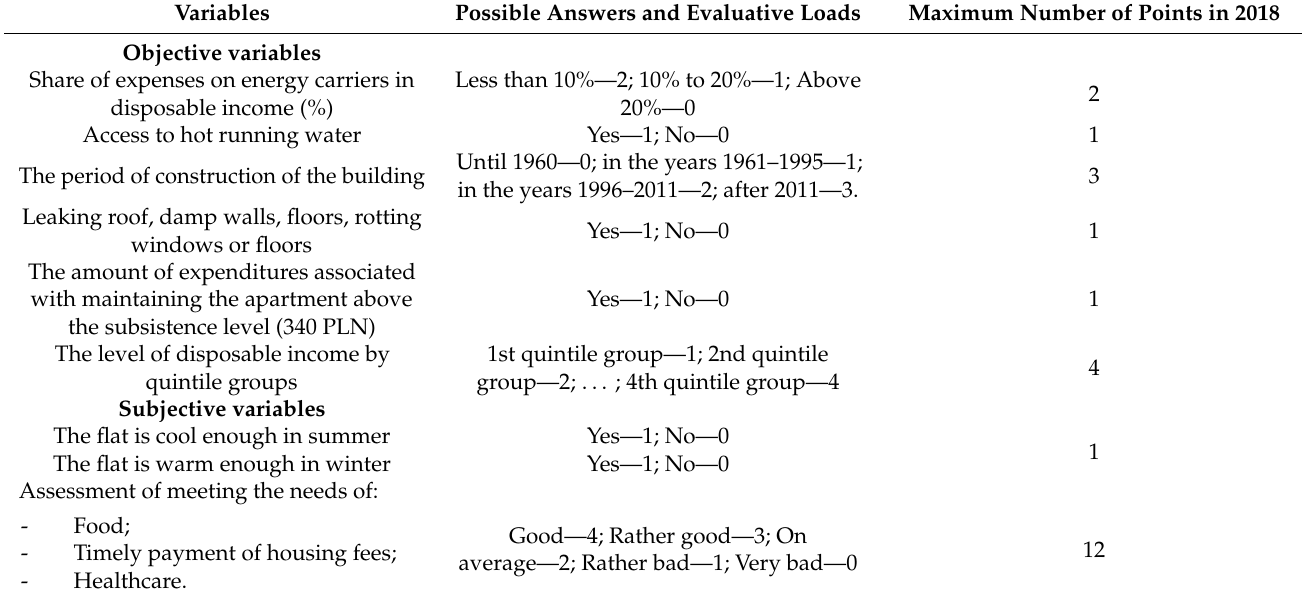
Table 1. Aggregate index of energy poverty (thermal comfort) for households of people aged 60 and older in Poland. Variables